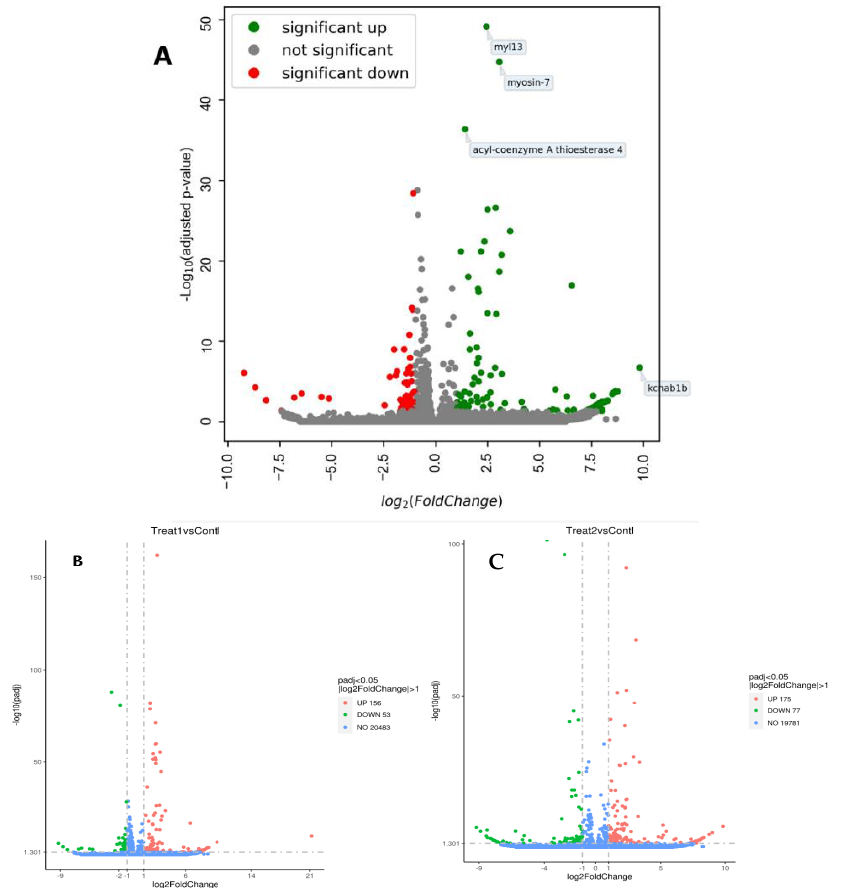
Figure 2. Volcano plot showing the distribution of DEGs in O. niloticus subjected to chronic stress. ( A ) Combined volcano plot for ammonia and stocking density treatments. The red dots represent the down-regulated genes, the green dots represent the up-regulated genes and the grey dots represent those that are not significantly regulated in the two treatments. ( B ) Volcano plot for ammonia treatment. The green dots represent the down-regulated genes, the red dots depict the up-regulated genes and the blue ones represent the genes that are not significantly up- or down-regulated under high ammonia concentrations. ( C ) Volcano plot for the stocking density treatment. The green dots represent the down-regulated genes, the red dots depict the up-regulated genes and the blue ones represent the genes that are not significantly up- or down-regulated under different stocking densities.